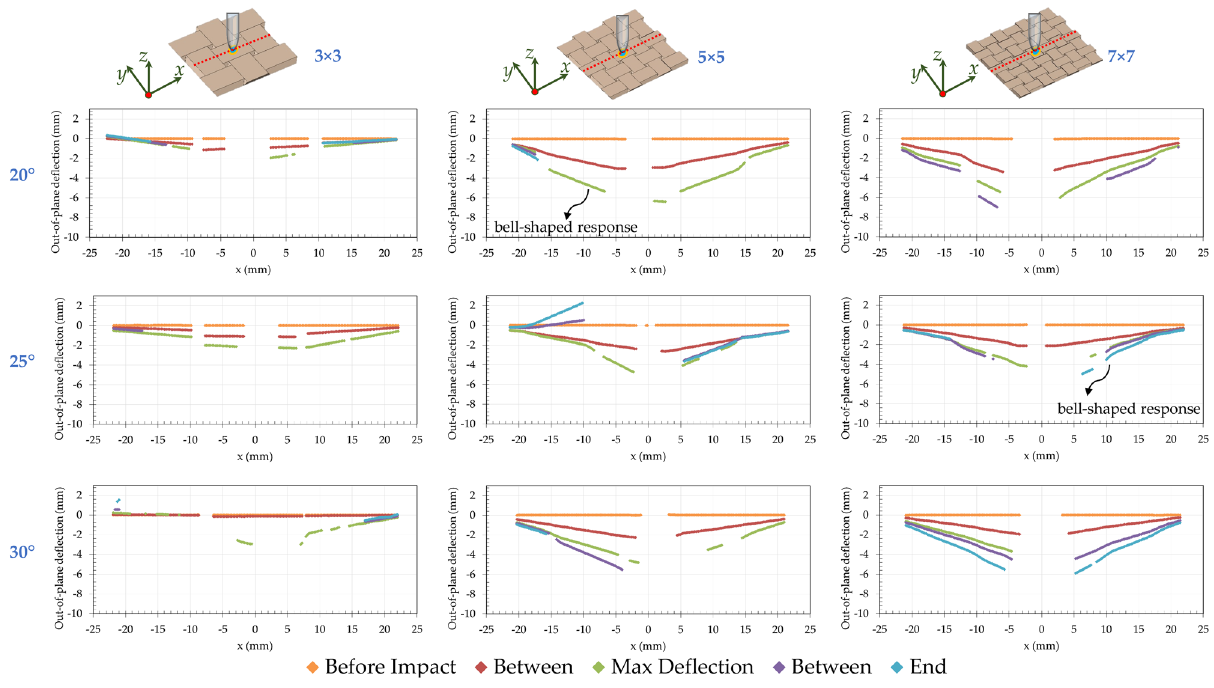
Figure 4. The deflection across the panels obtained by DIC at five stages of loading: architectured ceramics with the interlocking angles ( θ = 20°, 25°, and 30°) and number of blocks (3 × 3, 5 × 5, and 7 ×